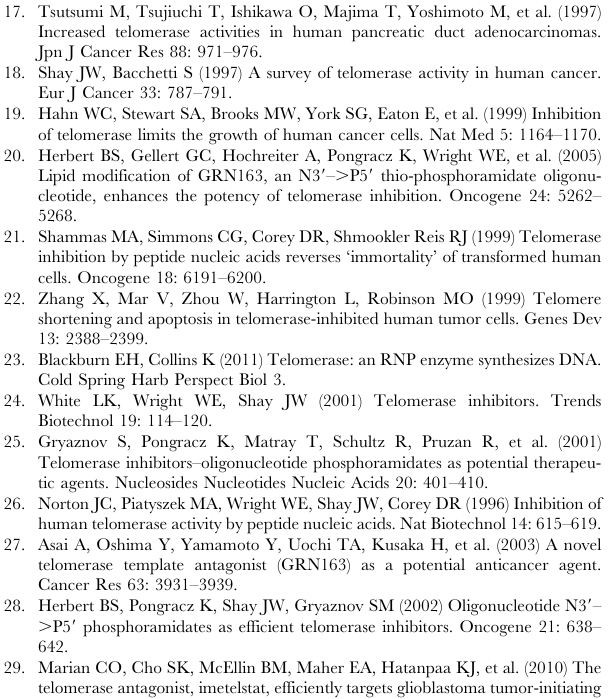
Figure S1 Lack of correlation among pancreatic cancer cell lines between levels of telomerase activity and size of telomeres and response to GRN163L. A) Median size of telomeres of each of the 10 pancreatic cancer cell lines as a function of their respective level of telomerase activity. B) Responses to GRN163L of each of the 10 cell lines as a function of their respective level of telomerase activity. Figure S2 Percent of GRN163L-treated cells with a sub- G1 DNA content. At the end of the growth curves, GRN163L- treated (GRN) and control (CTR, MIS) populations were analyzed for DNA content. Adherent cells were collected by trypsinization followed by centrifugation. Floating cells were collected by centrifugation, and the combined adherent and floating pool was analyzed by flow cytometry. Results are expressed as the percent of the total cells with a sub-G1 DNA content. Figure S3 Proliferation rates and telomere sizes as a function of chronological time in the GRN163L-treated CAPAN1 and CD18 cells. The number of population doublings achieved (Red circles) and median sizes of telomeres (Blue circles) are plotted as a function of chronological time (Days). The data shown is for the GRN163L-treated populations of CAPAN1 and CD18 cells. Dotted black lines extrapolate the initial growth rates of the GRN163L-treated populations before the start of crisis. Figure S4 Telomere size distribution over time in the GRN163L-treated CAPAN1 and CD18 cells. Telomere